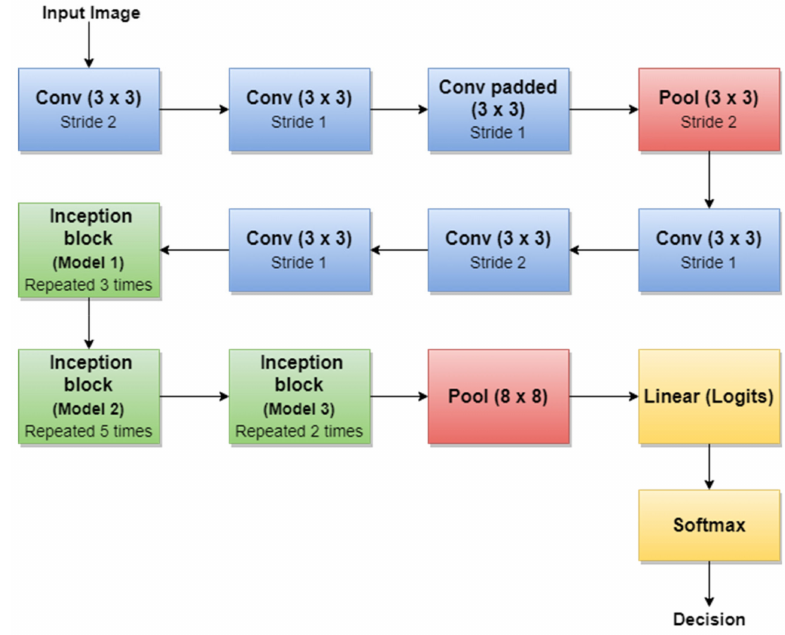
Figure 12. Inception v3 basic